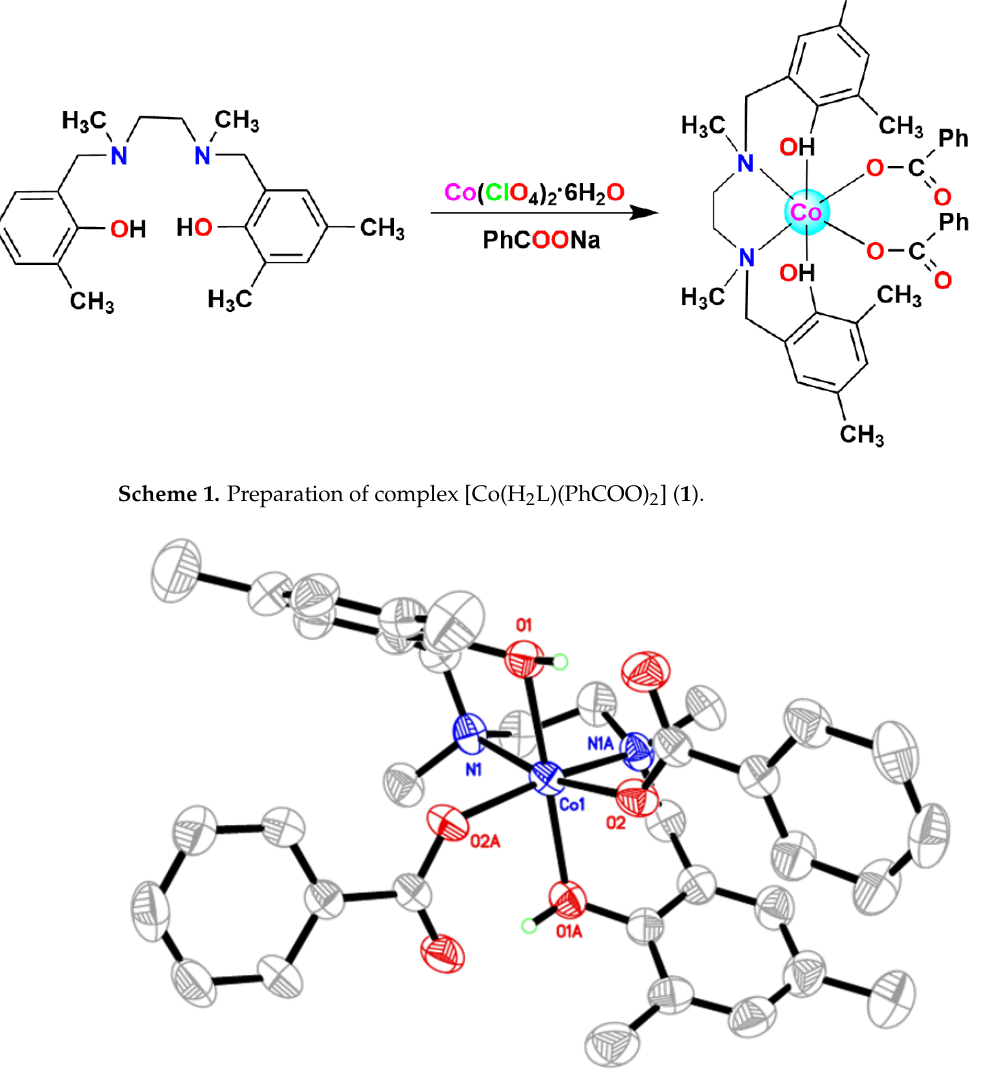
Figure 1. ORTEP representation of 1 showing 50% probability atomic displacement parameters. Asymmetric unit contains 2 symmetry-independent